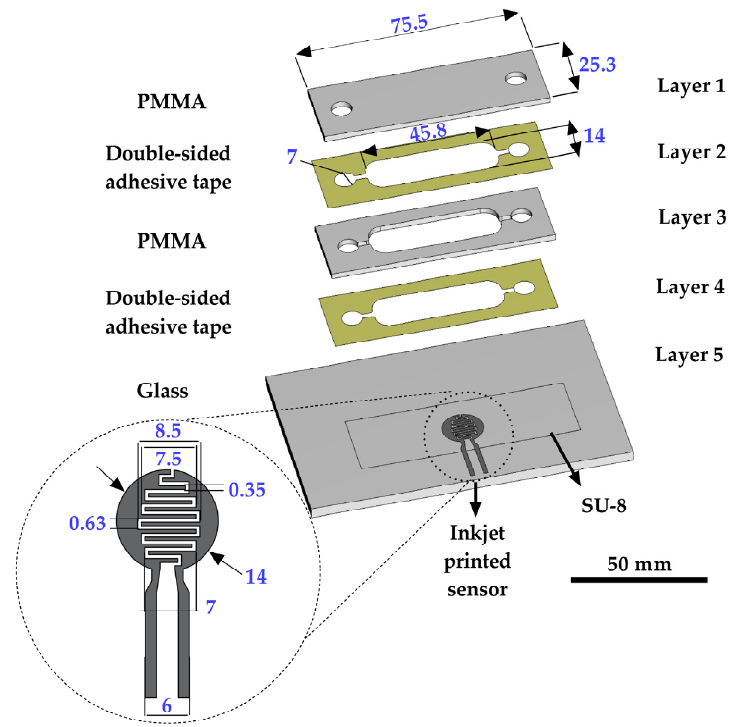
Figure 1. The multilayer structure and dimensions of the MF platform with an integrated inkjet- printed IDE sensor. All dimensions labeled in the figure are in mm.